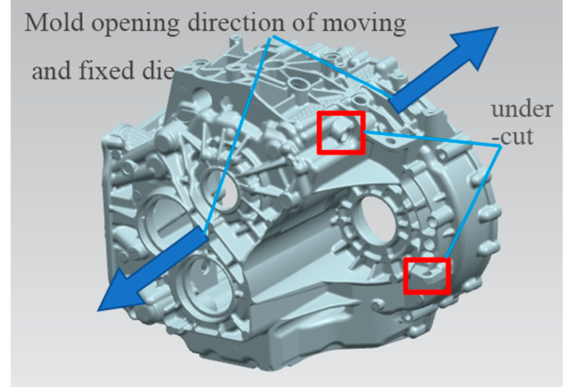
Figure 6. Casting structure diagram.